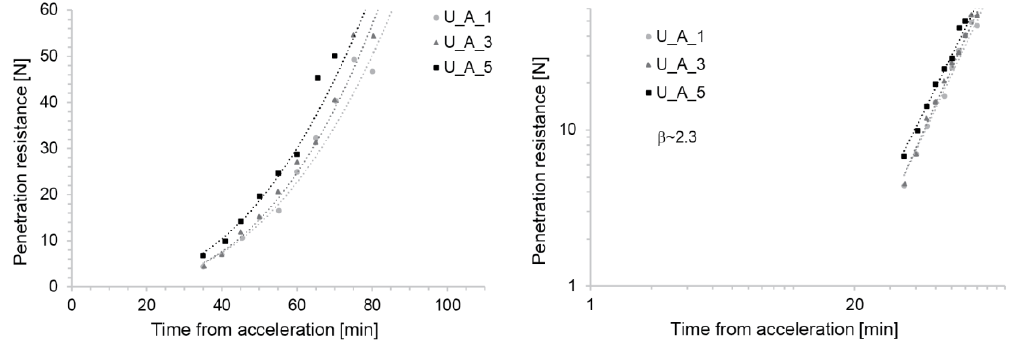
Figure 6. Strength evolution of the U_A Mix with aluminium sulfate solution as an accelerator with a decreased amount over time. (Left) Lin-lin scale. (Right) Log-log scale. The straight line obtained on the log-log scale highlights the fact that the yield stress evolution can well be fitted by a power-law (see Equation (3)).